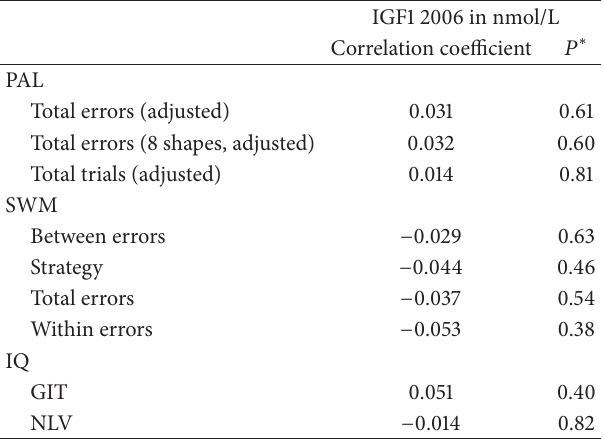
Table 3: Correlations between cognitive measures and IGF-1 levels ( 𝑛 = 278